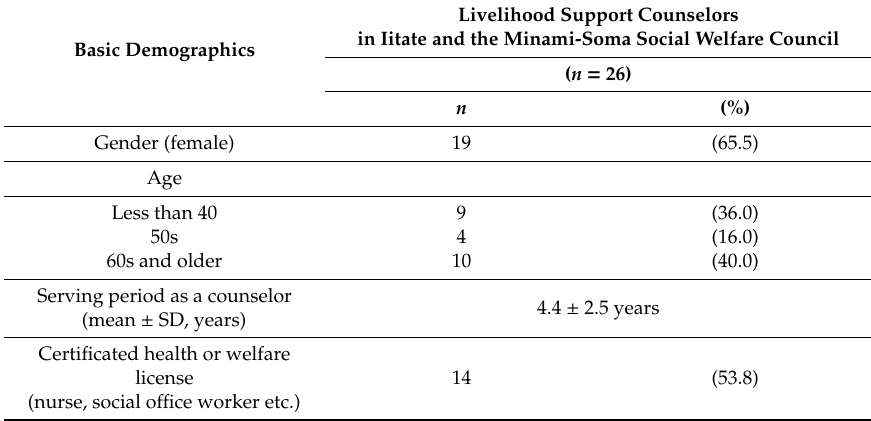
Table 4. Basic demographics of the subjects of the gatekeeper training program for radiation health anxiety and mental health